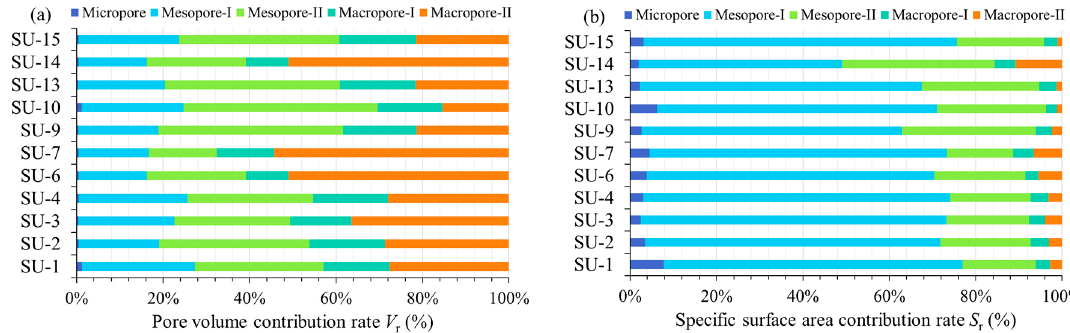
Figure 7. The contribution rate of V BJH and S BJH in five different size ranges pores. ( a ) Pore volume (PV) contribution rate of five different size classes pores; ( b ) specific surface area (SSA) contribution rate of five different size classes pores.